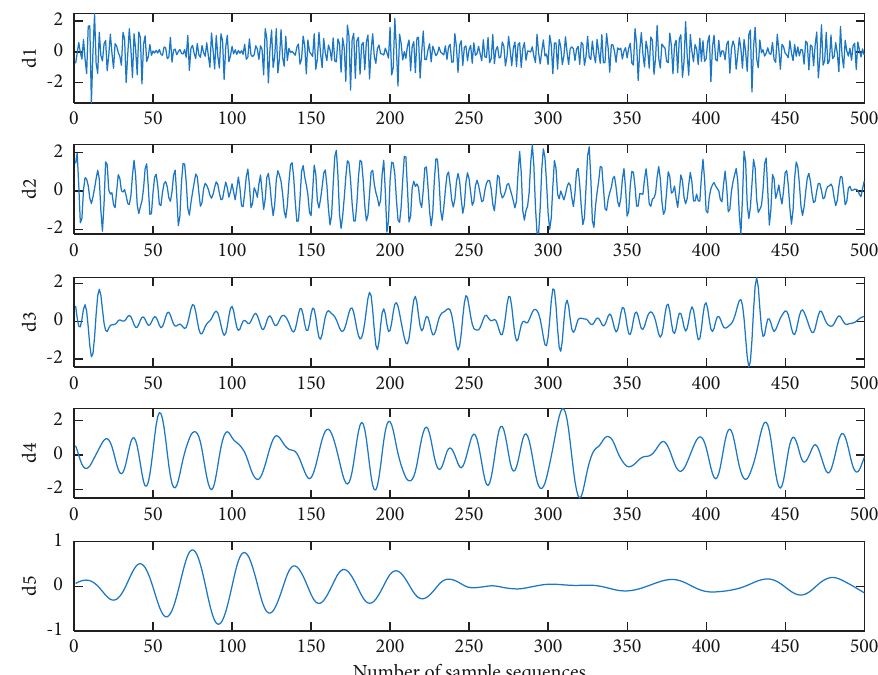
Figure 15: Wavelet decomposition chart of bearing’s inner ring at 38min.